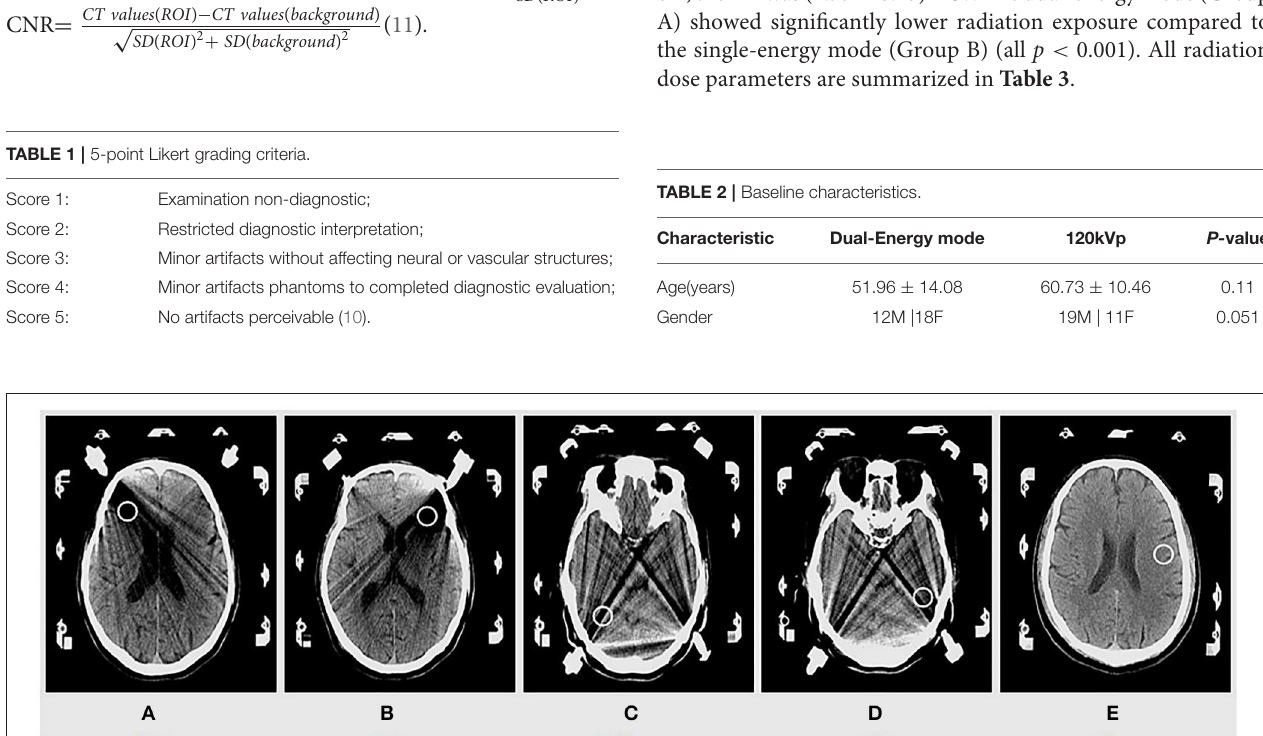
FIGURE 1 | Four regions of interest (ROIs) near the stereotactic nail (A–D) and one background ROI on brain tissue (E) were selected.